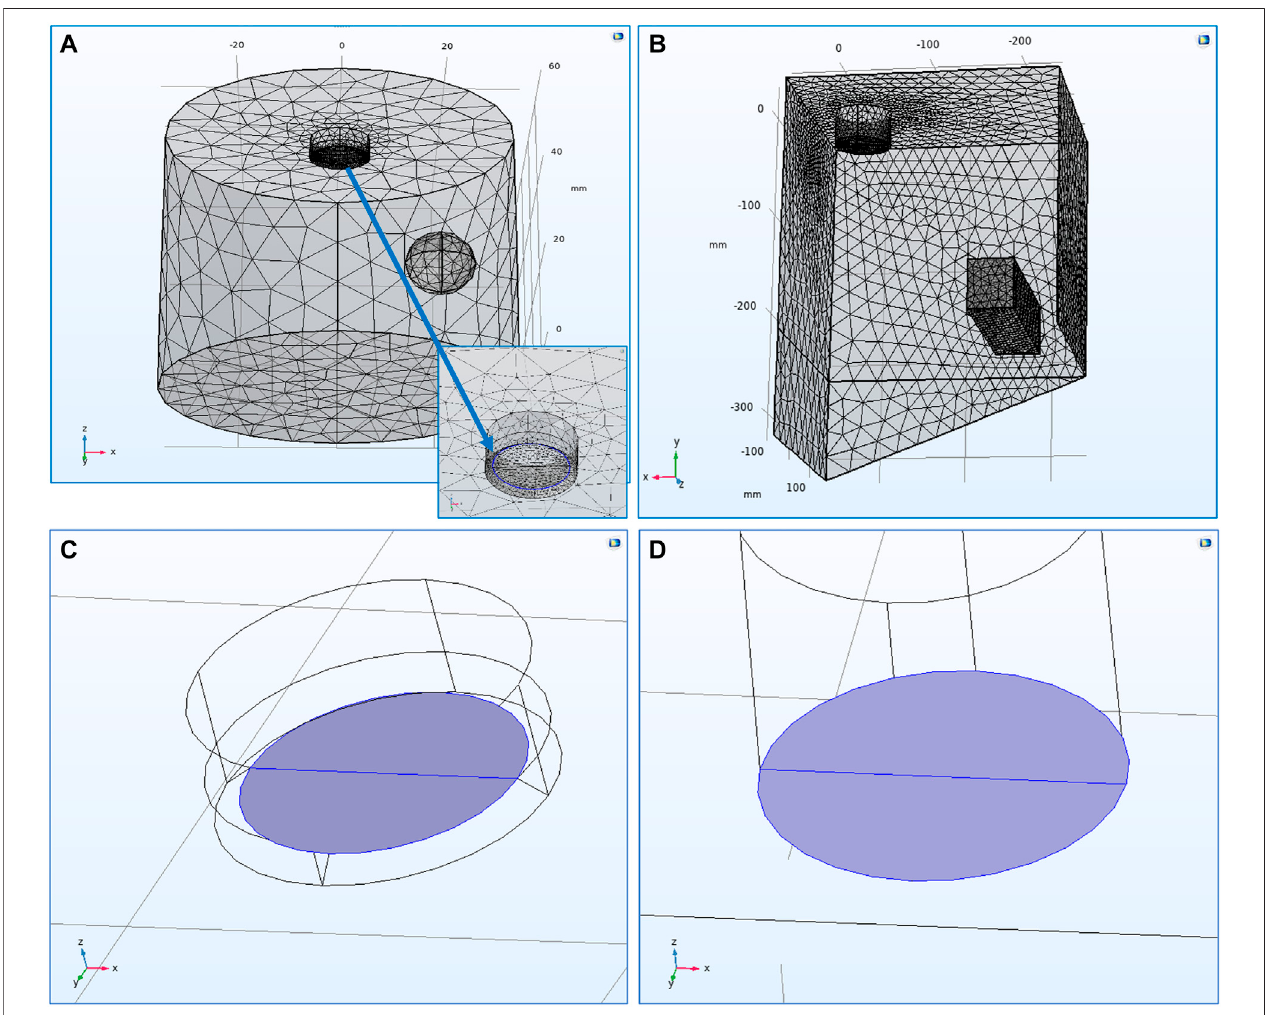
FIGURE1|(A) Meshspacingofthe3-D,laboratory-scale ( 0 . 2 dm 3 ) ,RDEgeometrydomainand (B) meshspacingofthe3-D,industrial-scale ( 18 dm 3 ) ,prototype electroforming reactor domain. The blue line in the zoom-in capture of fi gure (A) highlights the “ recess ” , transition edge of the stainless-steel disk electrode in the RDE model. The deposition (cathode) areas of (C) the laboratory-scale setup and (D) the scaled-up setup are also shown. The electrolytic volumes present a ration of 1:90 and the deposition areas a ratio of